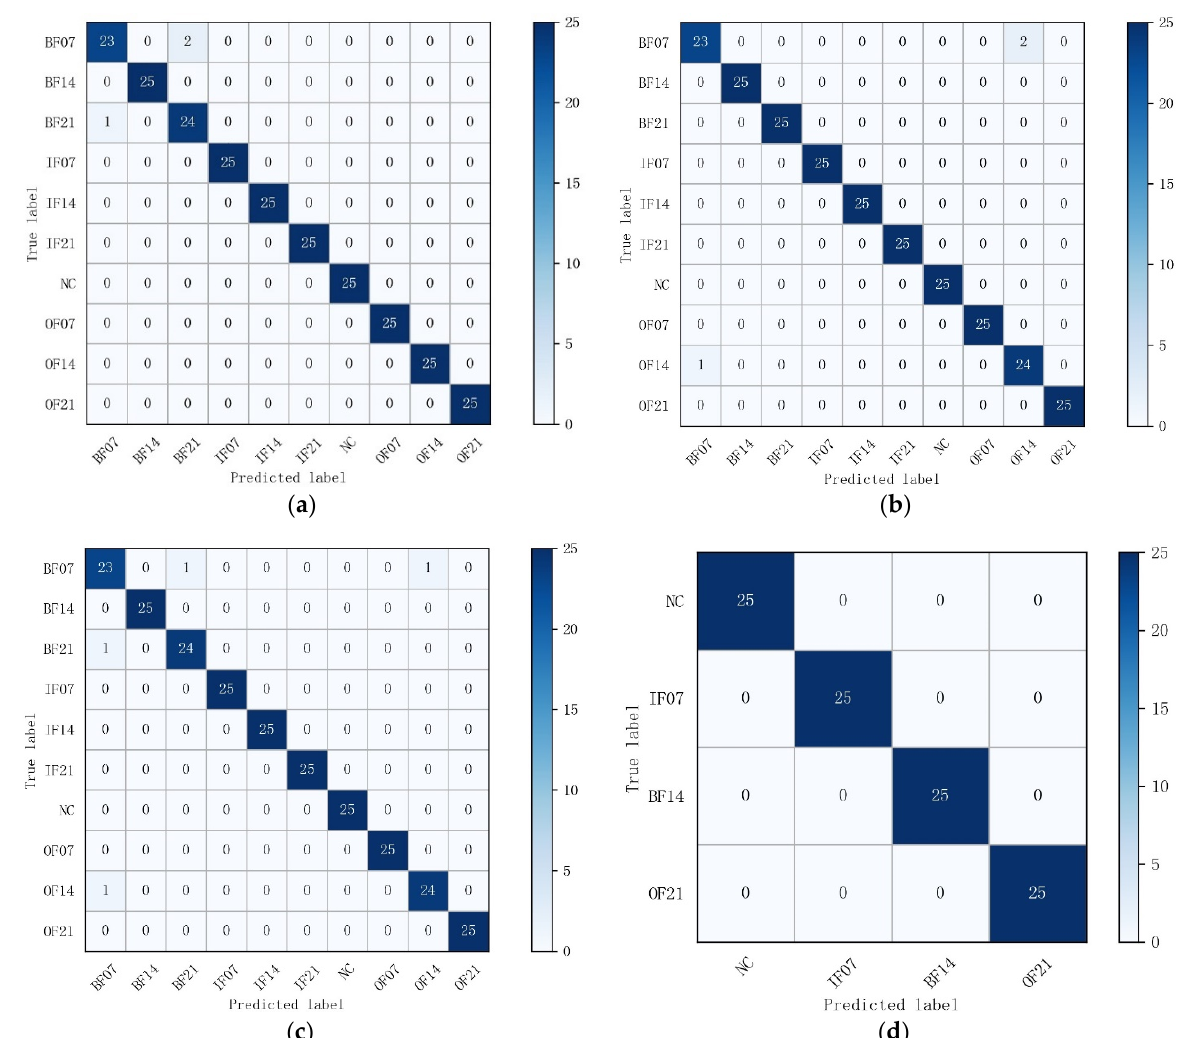
Figure 7. Confusion matrixes for each dataset: ( a ) Dataset A; ( b ) Dataset B; ( c ) Dataset C; ( d ) Dataset D.